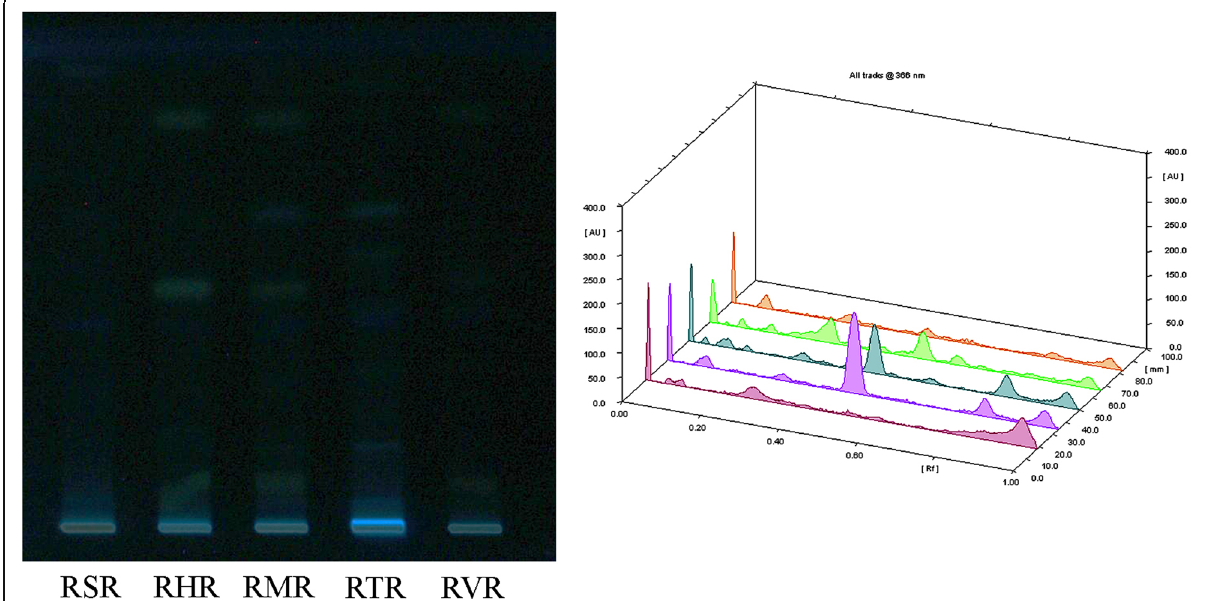
Fig. 3 HPTLC profile of aqueous extracts of various Rauvolfia species. RSR: R. serpentina root, RHR: R. hookeri root, RMR: R. micrantha root, RTR: R. tetraphylla root, RVR: R. verticillata